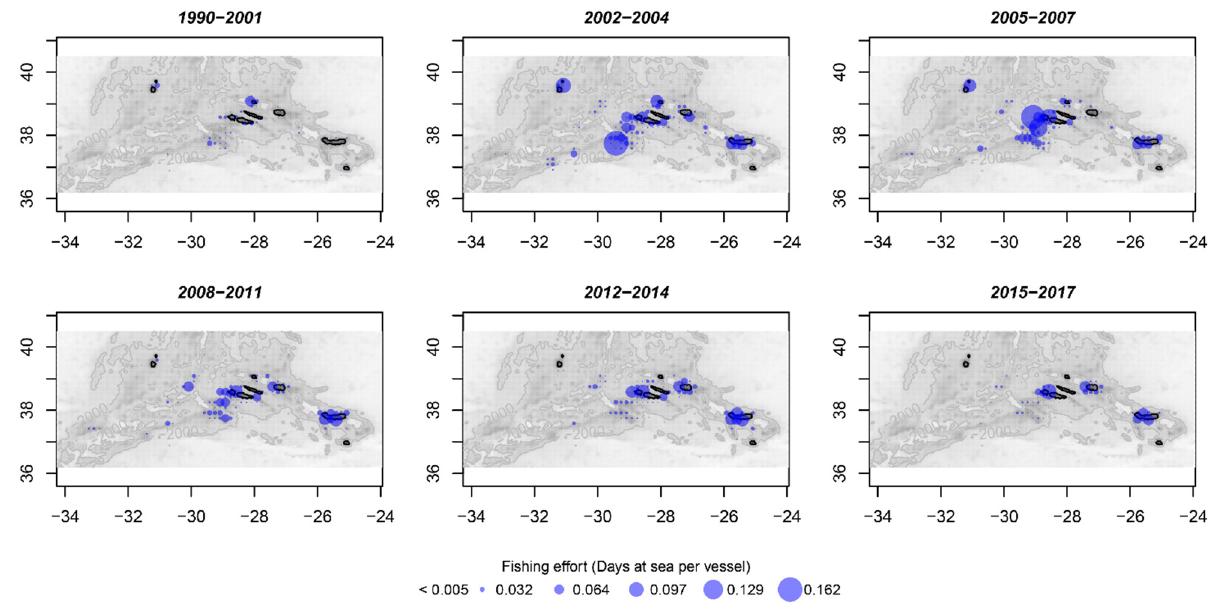
Figure 10. Spatial distribution of average fishing effort (days at sea per vessel) of the Azorean fishing fleet in 1990–2017. Gray scale indicates the bathymetry (seafloor depth) from shallow (dark gray) to deep (white) waters. Black color represents a land mask. Blue bubbles represent the proportional fishing effort. Data from the EU Data Collection Framework (DCF) port inquiries.